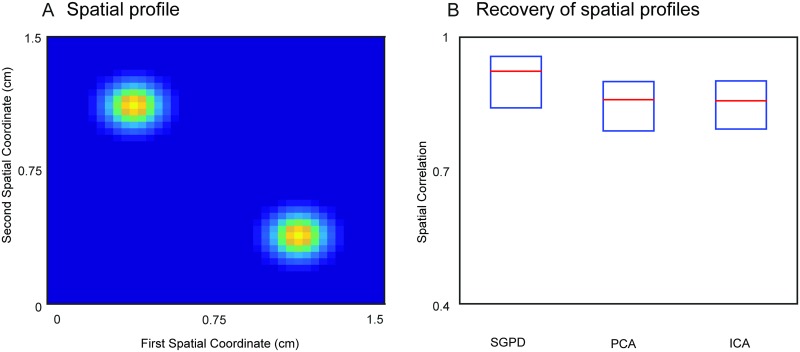
Simulation results on recovery of spatial profiles of non-contiguous dynamic components.Performance of SGPD, ICA and PCA in recovering an oscillatory signal with a non-contiguous spatial profile. A) Ground truth spatial profile of the dynamic component. B) Performance of SGPD, PCA and PCA in recovering the spatial profile of a dynamic component with bi-modal spatial profile on a two-dimensional cortical sheet. The performance is quantified as spatial correlation with the ground truth.